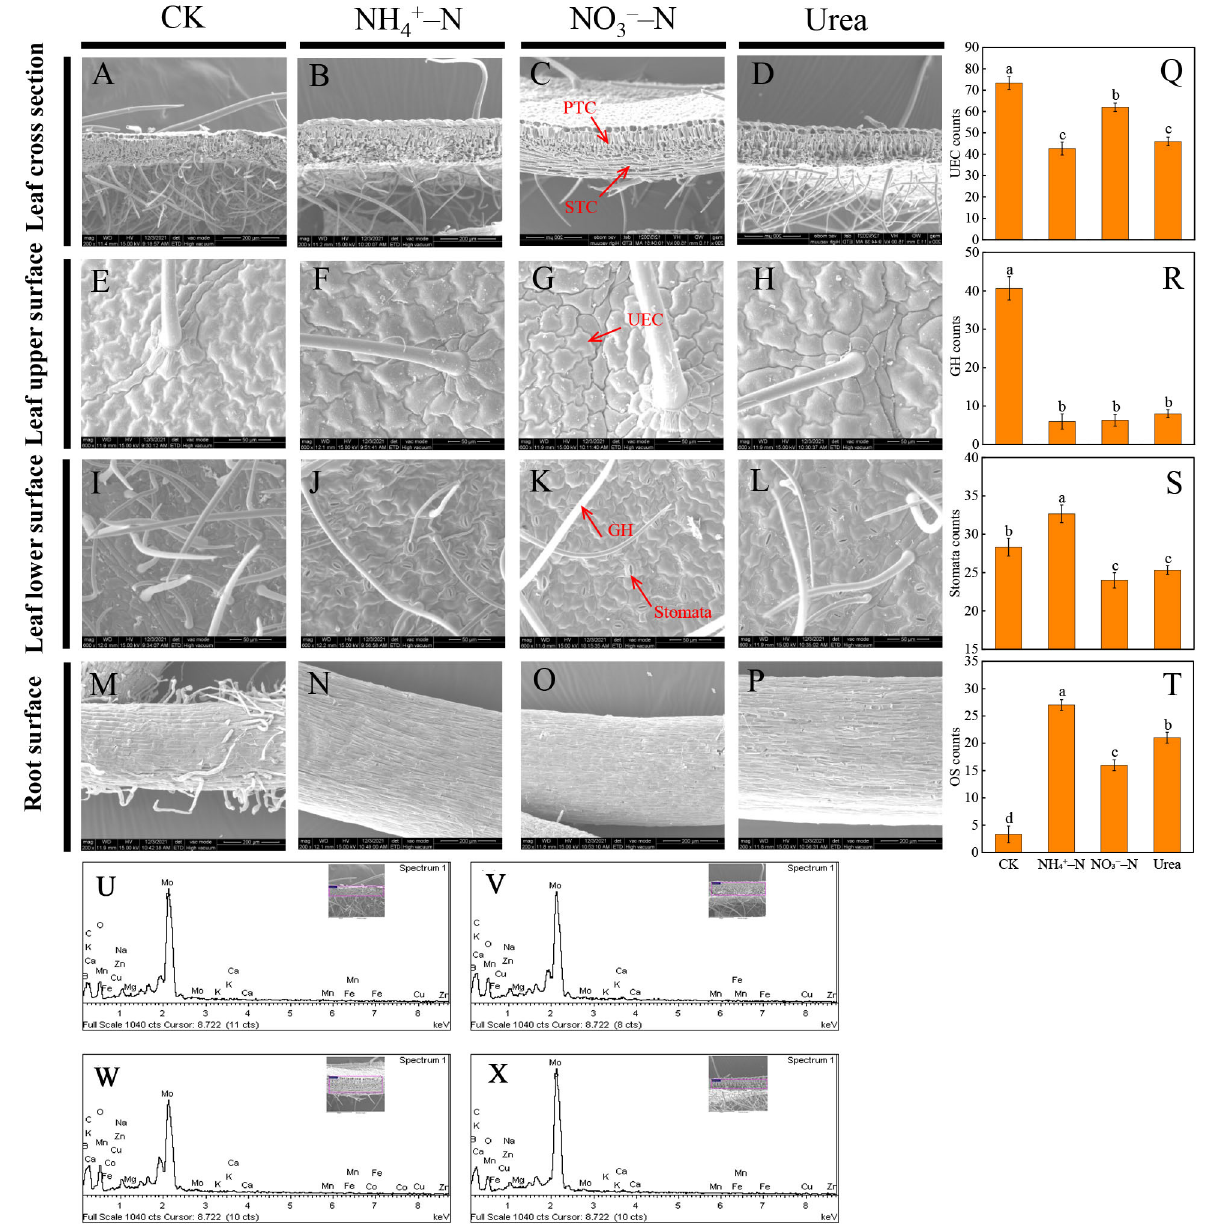
Figure 2. Scanning electron micrographs showing the leaf cross-sections (( A – D ); scale bar is 200 µ m), leaf upper surface (( E – H ); scale bar is 50 µ m), leaf lower surface (( I – L ); scale bar is 50 µ m) and root surface (( M – P ); scale bar is 200 µ m) after 60 days of treatment with different N forms. The counts of UEC ( Q ), GH ( R ), stomata ( S ) and OS ( T ) with different N forms. X-ray energy spectrogram of leaf cross-sections with different N treatments (panels ( U – X ) represent the CK, NH 4+ –N, NO 3 − –N and urea treatments, respectively). PTC, palisade tissue cell; STC, spongy tissue cell; UEC, upper epidermal cell; GH, glandular hairs; OS, open stomata.